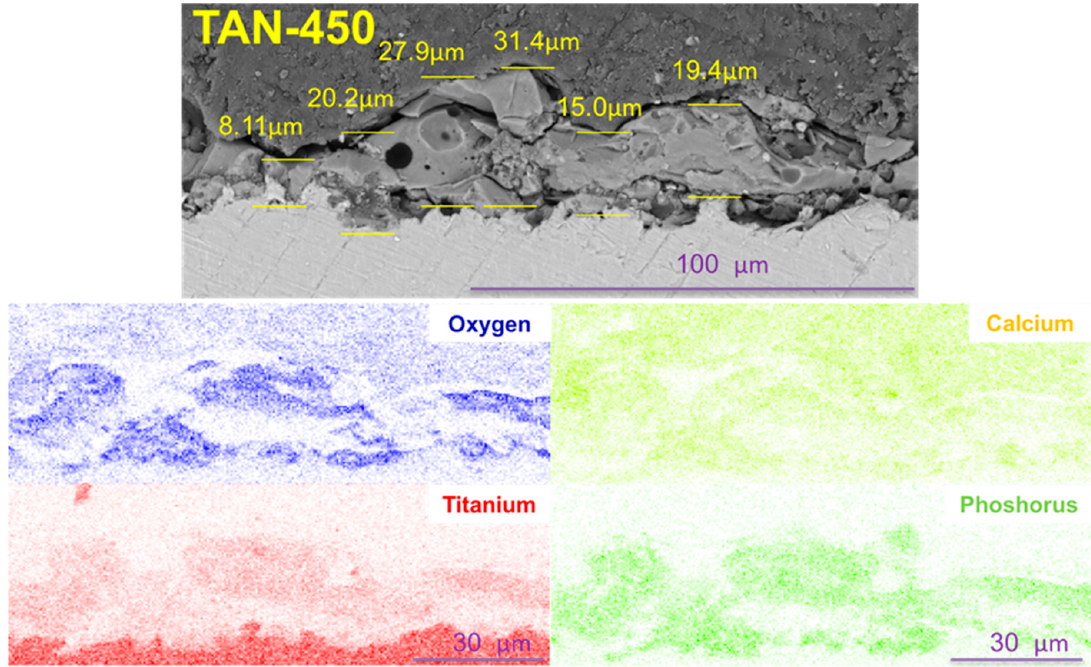
Figure 4. Cross sections of: TAN-450 and EDX mapping of selected part of oxide layer.